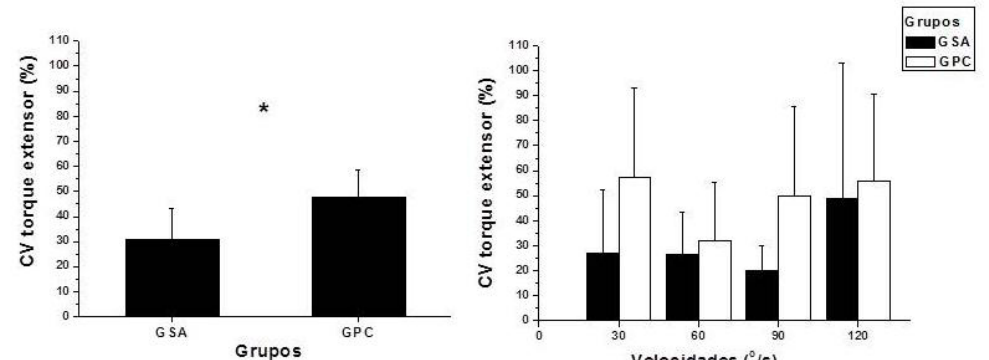
Figura 7. Média e desvio padrão do coeficiente de variação do torque extensor nos grupos GSA e GPC e média e desvio padrão do coeficiente de variação do torque nas velocidades 30, 60, 90 e 120°/s. * diferença estatisticamente significante entre grupos.